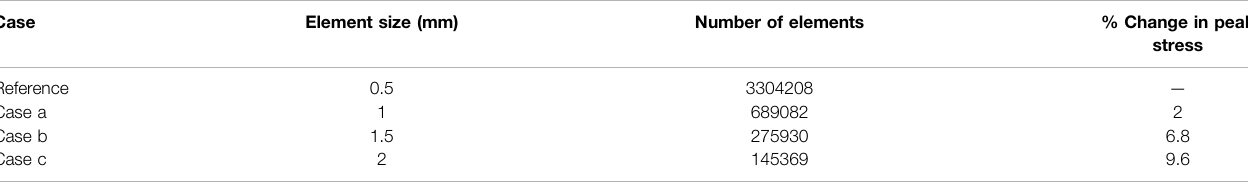
TABLE 2 | Sensitivity analysis on the mesh density of the